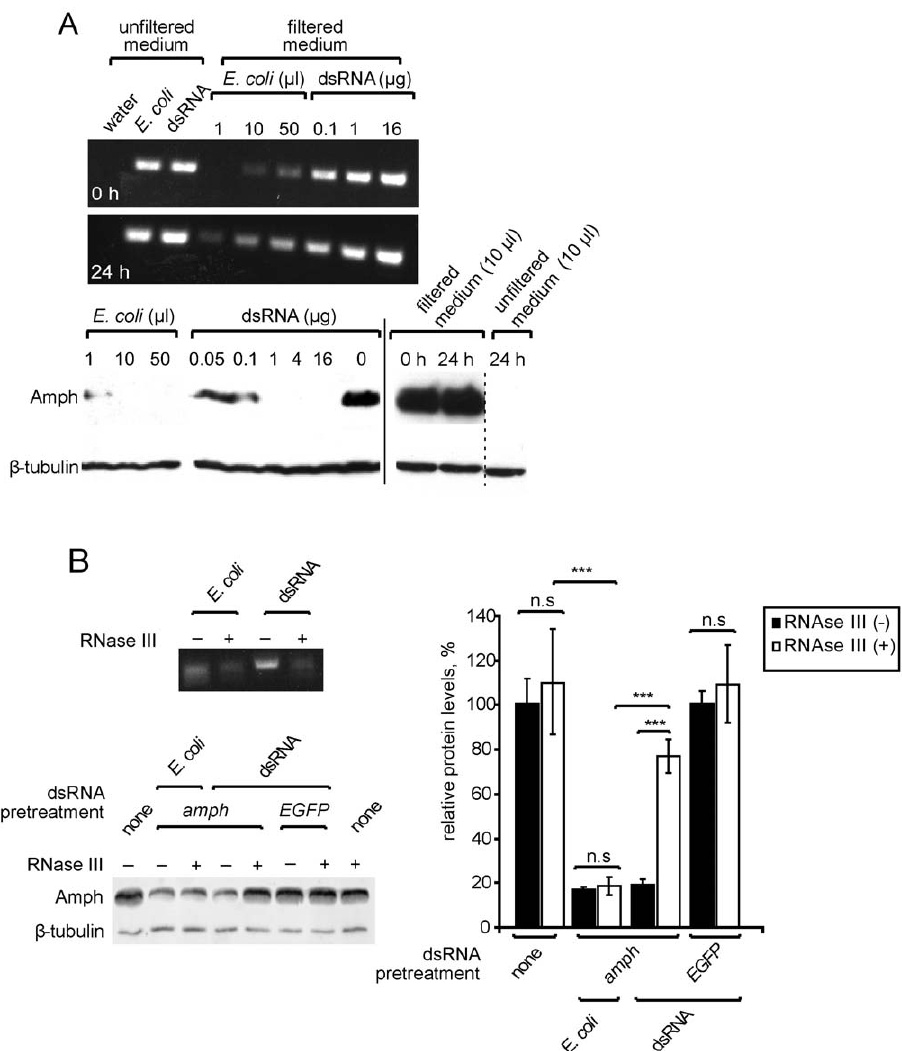
Figure 3. Free dsRNA cannot account for RNAi mediated by E.coli . ( A ) dsRNA leaking into the culture medium from E. coli that express dsRNA does not account for RNAi. Top: RT-PCR detection of amph dsRNA in cell culture medium incubated with either dsRNA-expressing E. coli or naked dsRNA, either unfiltered, or filtered through a 0.22 m m filter to remove bacterial cells. Samples were taken immediately (0 h) and 24 hours after E. coli or dsRNA was added. Bottom: Western blots showing amphiphysin and b -tubulin expression in S2 cultures incubated for 72 hours with varying amounts of amph dsRNA-expressing E. coli , naked amph dsRNA, or treated with 10 m l of unfiltered or filtered cell culture medium recovered from cultures incubated for 24 hours with amph dsRNA-expressing E. coli . ( B ) RNAi mediated by E. coli is RNase III insensitive. Top left: RT-PCR detection of amph dsRNA in filtrates of cell culture medium incubated with either dsRNA-expressing E. coli or naked dsRNA, treated ( + ) or non-treated ( 2 ) with RNase III. Samples were taken 24 hours after E. coli or dsRNA was added. Bottom left: Western blots showing amphiphysin protein levels in S2 cultures incubated with amph or EGFP dsRNA, or E. coli expressing amph dsRNA, treated ( + ) or non-treated with RNase III ( 2 ). Right: bar graph shows protein levels of amphiphysin relative to b -tubulin. Values are averages of four independent experiments. Error bars indicate standard error of the mean. *** P , 0.005, n.s. P . 0.05; two-tailed t-test.